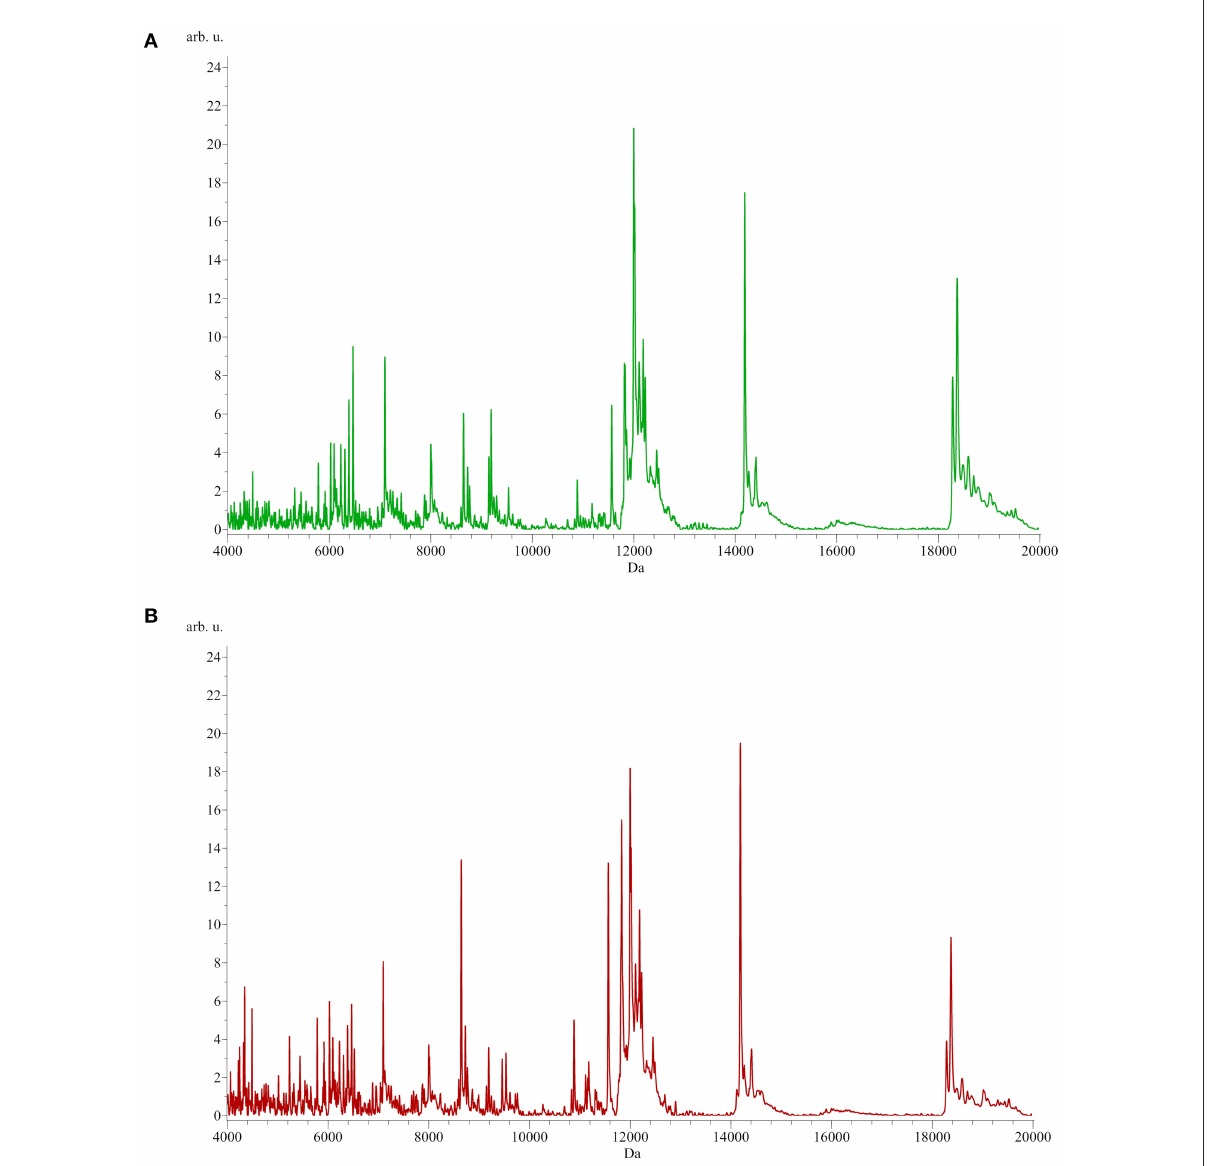
FIGURE1 Average MALDI-TOF mass spectra of milk samples from group L [SCC < 200,000 cells/ml, (A) green] and H [SCC > 200,000 cells/ml, (B) red]. x-axis: m/z, y-axis: arbitrary units of